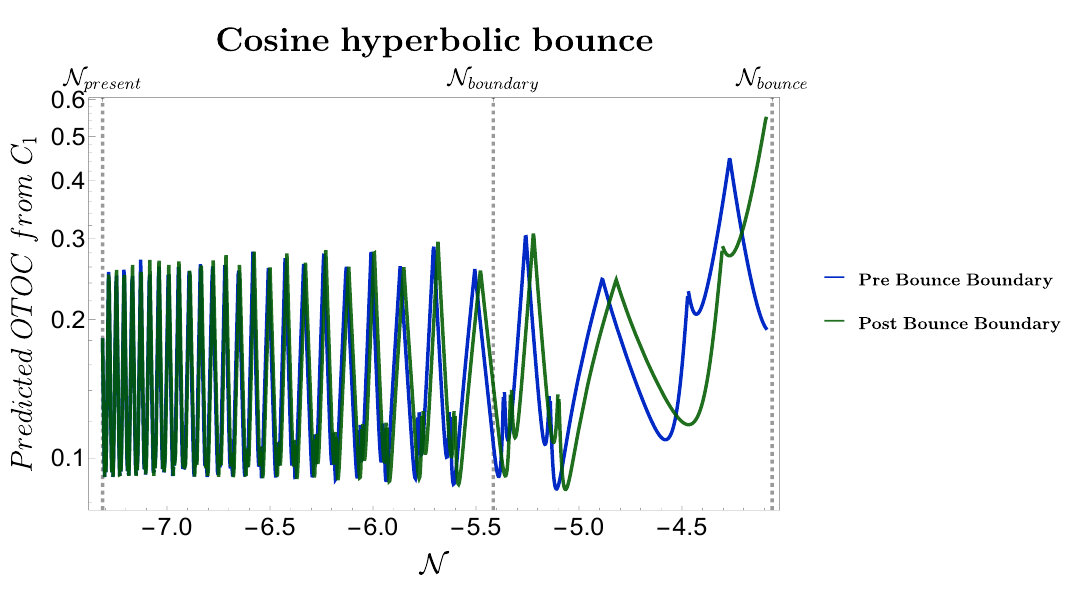
Figure 23: Predicted OTOC from linearly weighted complexity outside bouncing re- gion with respect to number of e-foldings.